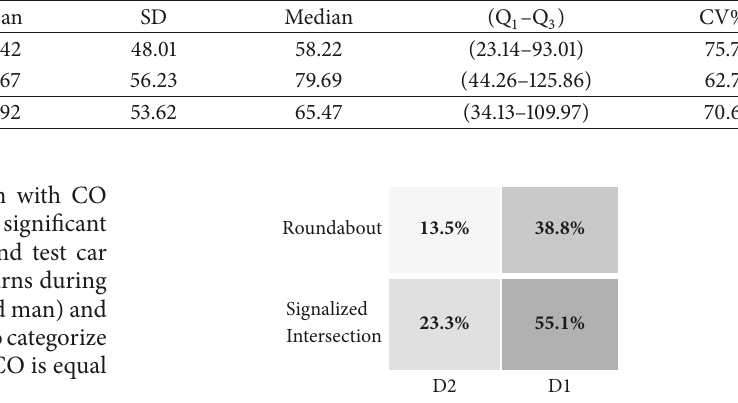
Table 12: Descriptive statistics for NO 𝑋 emissions (mg) by intersection type (traffic condition = peak).